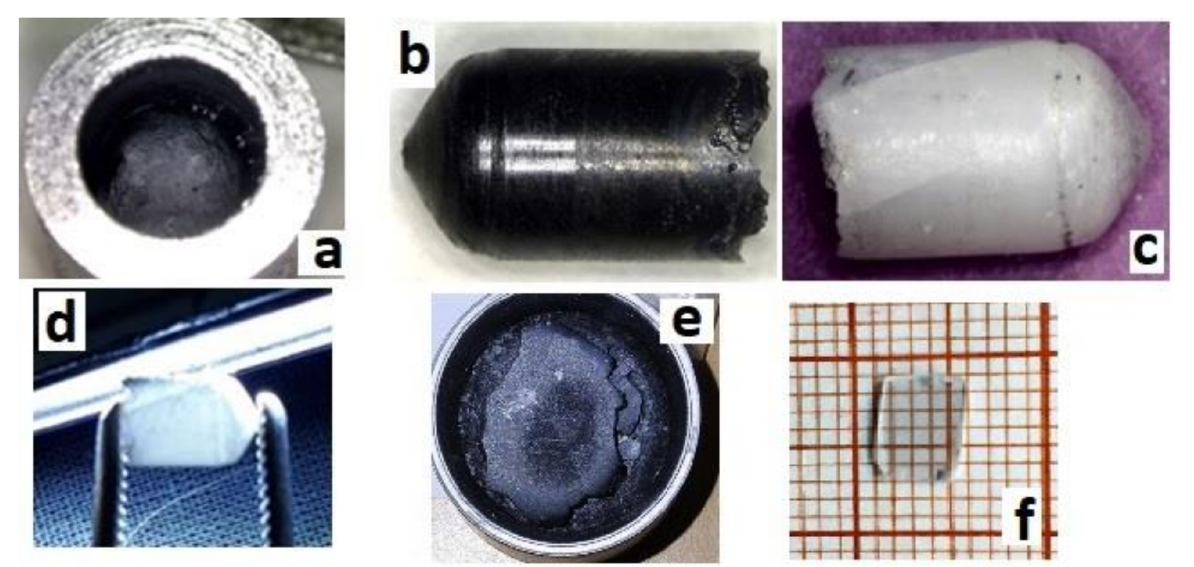
Figure 3. Obtained sesquioxide crystals: ( a ) Y 2 O 3 with the diameter 6 mm as grown in crucible, ( b ) Y 2 O 3 as grown extracted from the crucible, ( c , d ) Y 2 O 3 after annealing in air at 1200 ◦ C, ( e ) as- grown Y 1.1 Sc 0.9 O 3 , and ( f ) polished sample with a thickness of 0.5 mm cut from the same Y 1.1 Sc 0.9 O 3 ingot after the annealing in air at 1200 ◦ C. Y 2 O 3 crystals were annealed at 1200 ◦ C for 12 h to reduce the number of